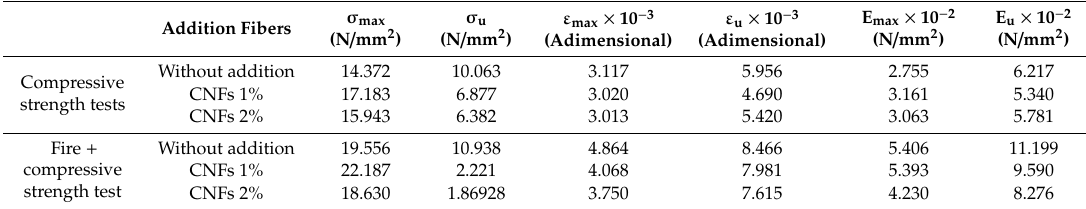
Table 4. Most representative mean values of the three specimens for each concrete type subjected to compressive strength testing and direct fire testing, with the di ff erent addition percentages. Addition